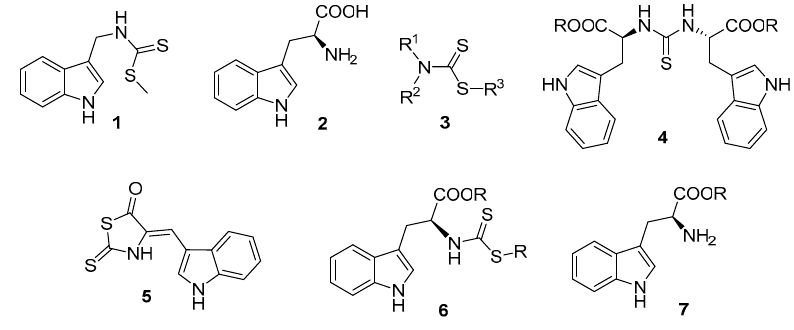
Figure 1. Chemical structures for compounds 1 – 7 .